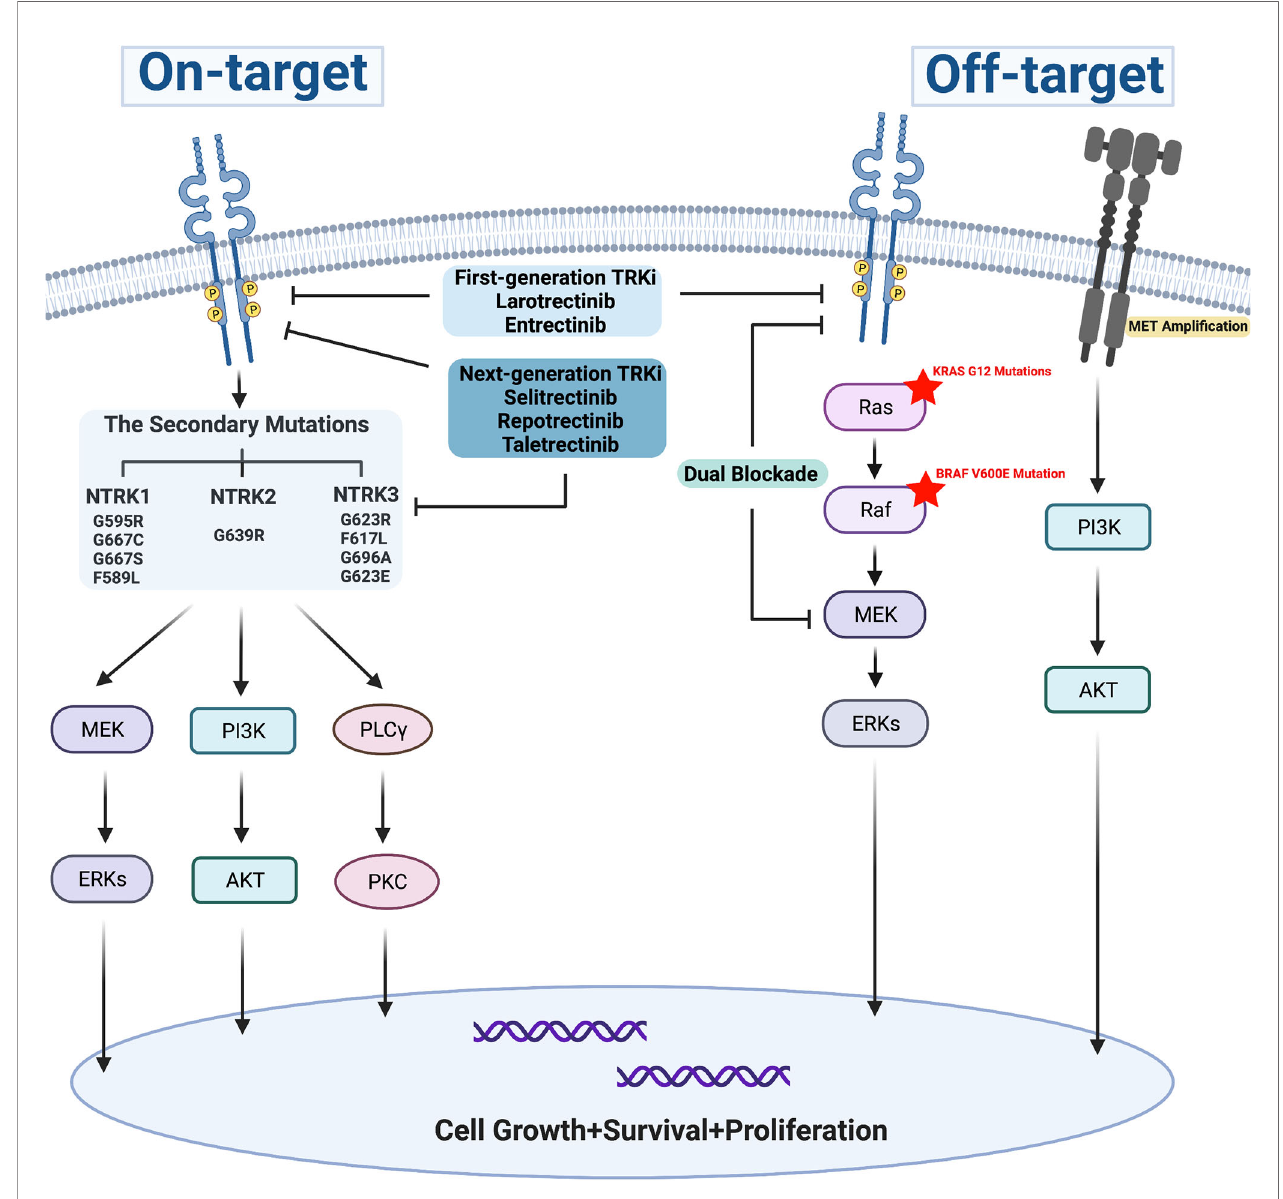
FIGURE 2 | Resistance mechanism for fi rst-generation TRK